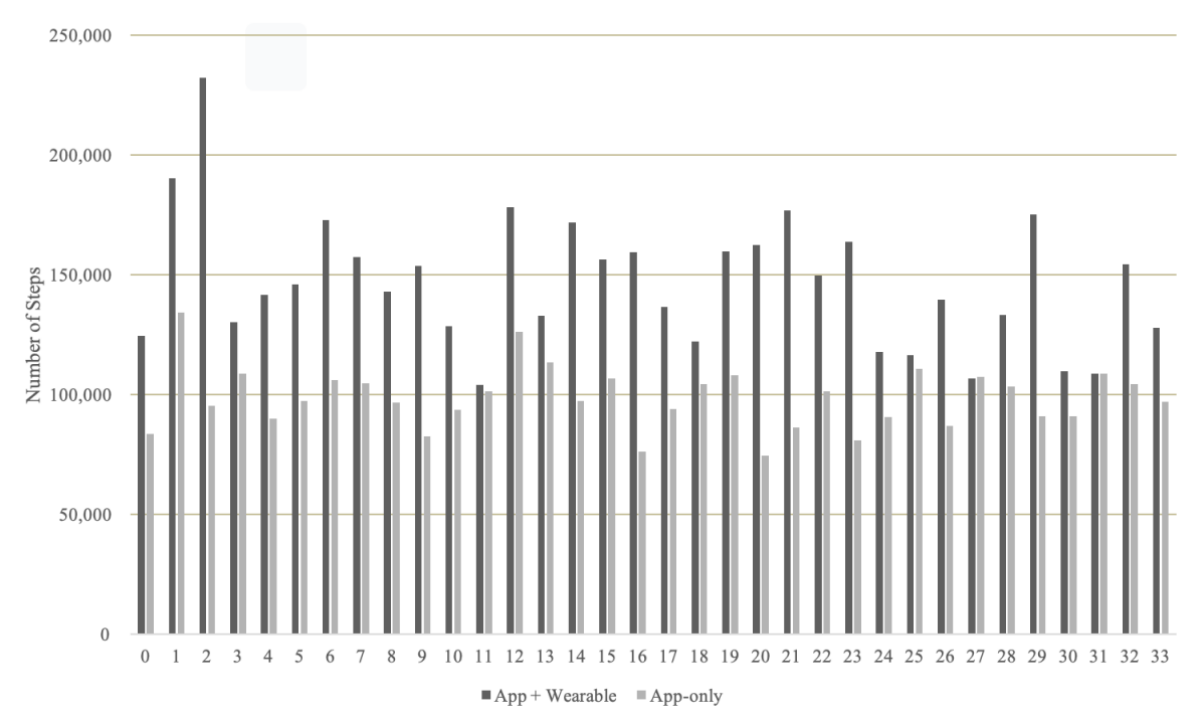
Figure 5. Changes in daily steps per group.